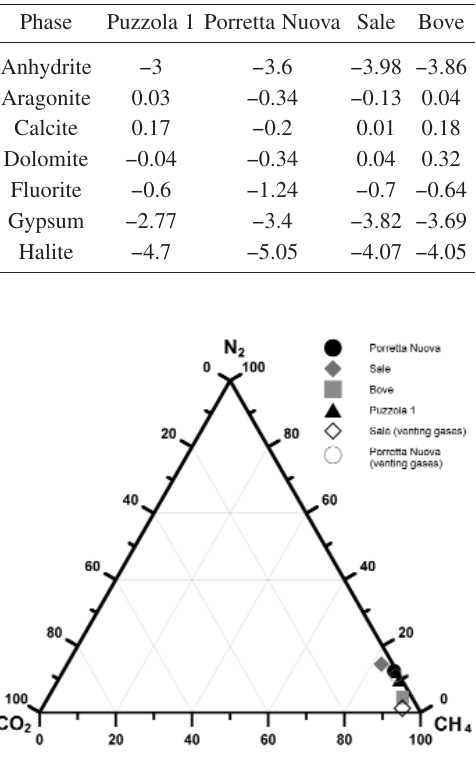
Fig. 9. N 2 -CO 2 -CH 4 diagram showing a CH 4 -domi- nated gas phase for both dissolved and bubbling gases. 520